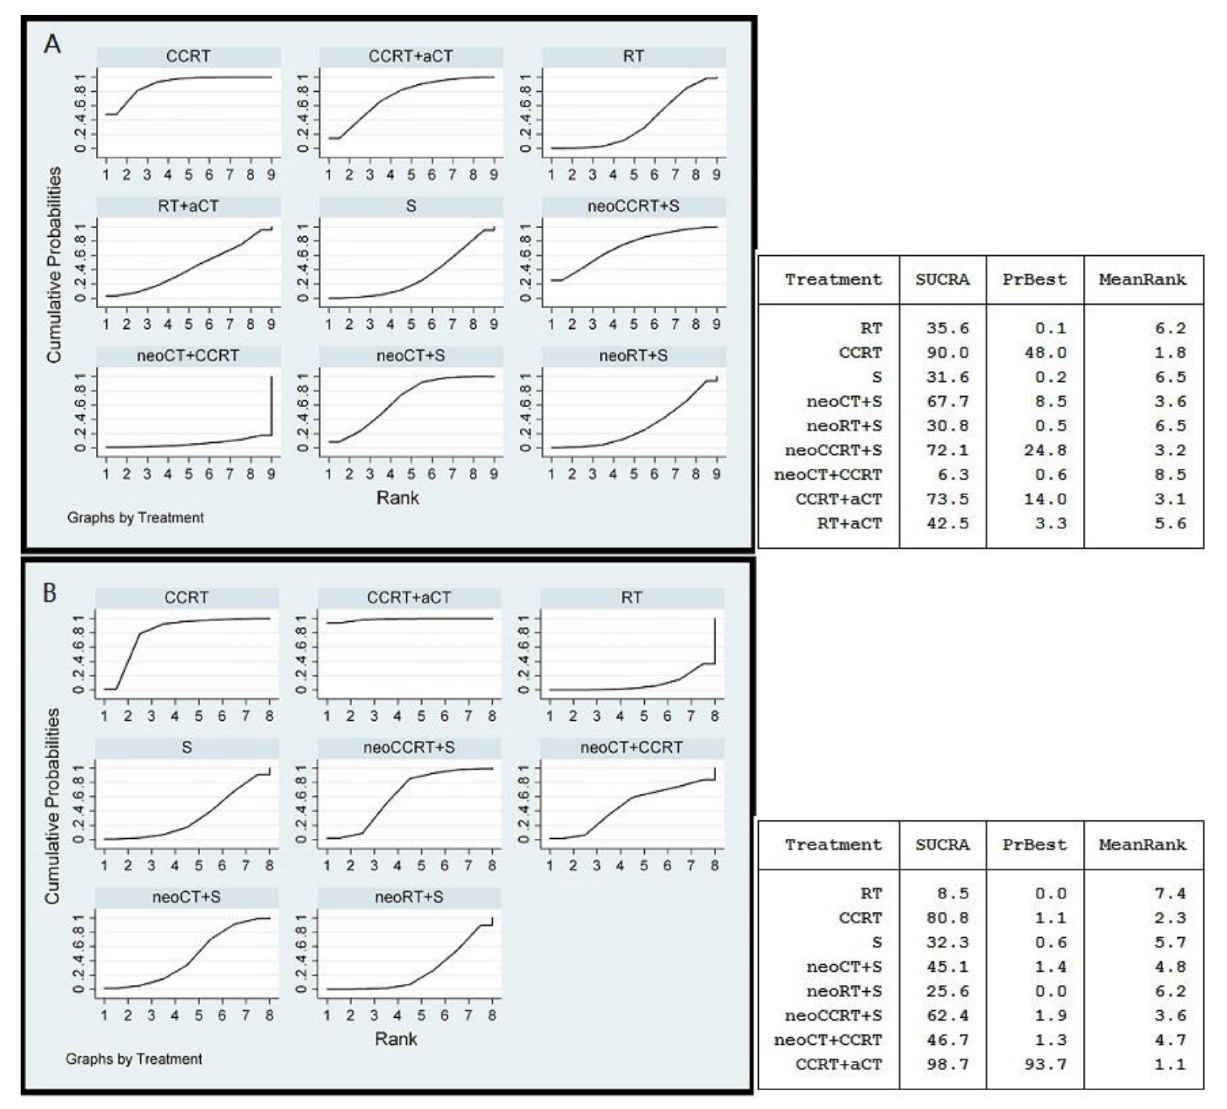
Figure 3A , CCRT (0.900) and CCRT plus adjuvant CT (0.735)